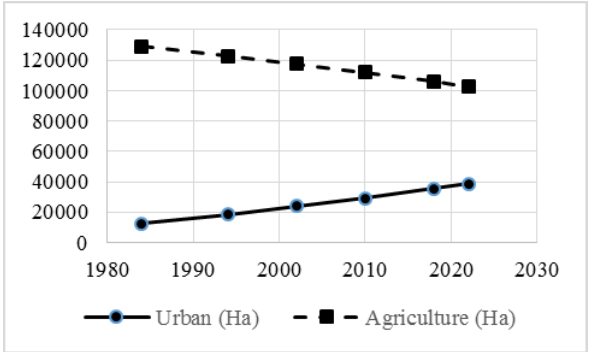
Figure 4. Change of urban and agricultural areas (1984-2022) As for the overall change between 1984 and 2018, the rate is about 186.3%. Thus, about 23000 ha in total were urbanized during the same period (1984-2018). More The table 4 shows that the period with the highest population growth in the region is 1984-1994 with a growth rate of more than 50%. The same table also shows that the region has an annual urbanization opening of about 600 ha on average.